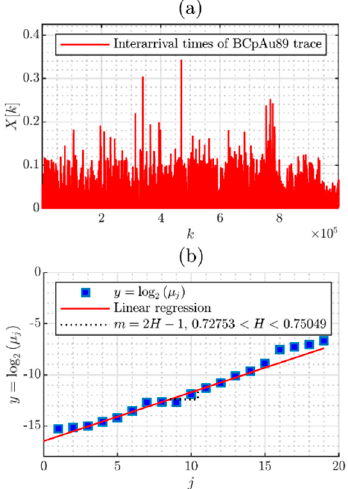
Figure 7. Detection of long-range dependence (LRD) in a series of times from the estimation of the Hurst parameter by means of log-scale diagram (LD): ( a ) Time series with LRD; ( b ) log-scale diagram.